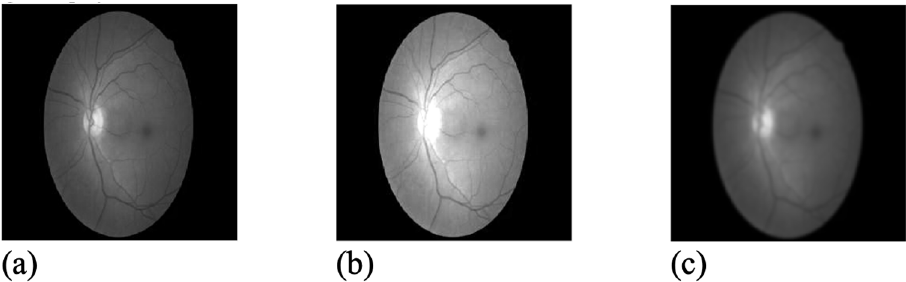
Figure 1. ( a ) The green retinal channel, ( b ) result of contrast improvement, and ( c ) result of applying Gaussian filter for smoothing the image. Gaussian filter for smoothing the